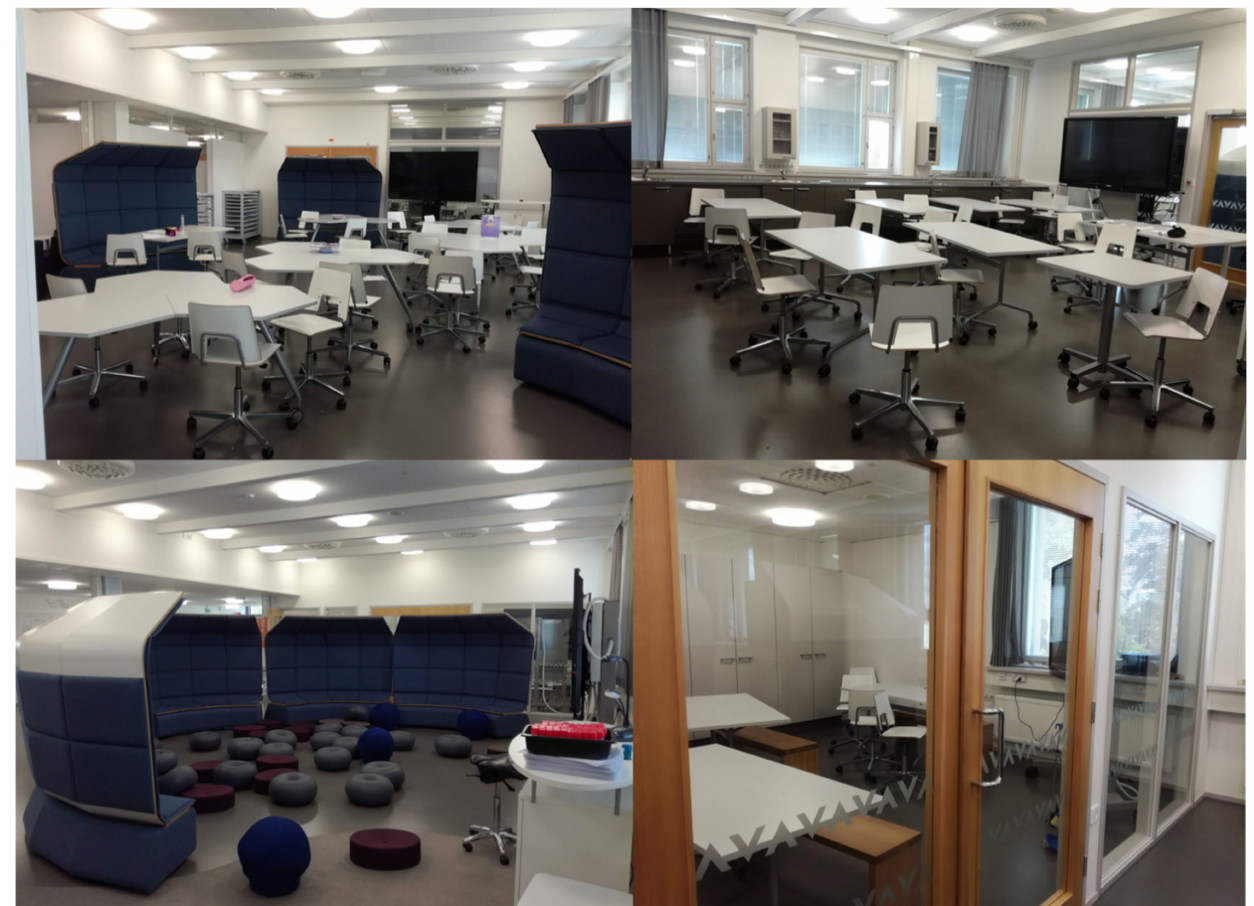
Figure 1. The open learning space shows several areas for work as well as a quiet work room allowing for division of the class of about 70–80 students into smaller groups with mobile and dynamic furniture.